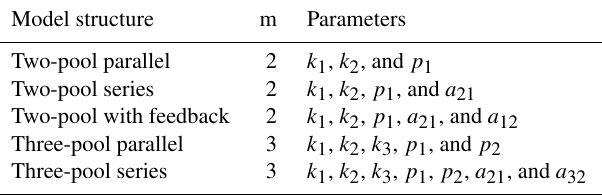
Table 1. Fitted model structures and parameters. m : number of C pools. k 1 , k 2 , k 3 : decomposition rates of pools 1, 2, and 3, respec- tively. p 1 , p 2 : initial proportions of C in pools 1 and 2, respectively. a 21 : transfer rate from pool 1 to pool 2. a 12 : transfer rate from pool 2 to pool 1. a 32 : transfer rate from pool 2 to pool